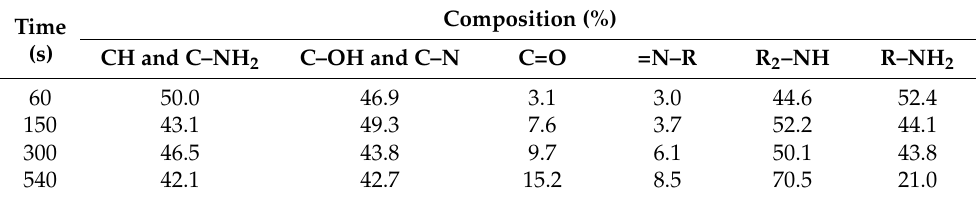
Figure 5. XPS C 1S and N 1S spectra of polydopamine deposited on mica for different immersion times (0, 60, 150, 300, and 540 s). Table 2. Chemical composition of PDA/mica derived from C 1S and N 1S signals based on immer- sion